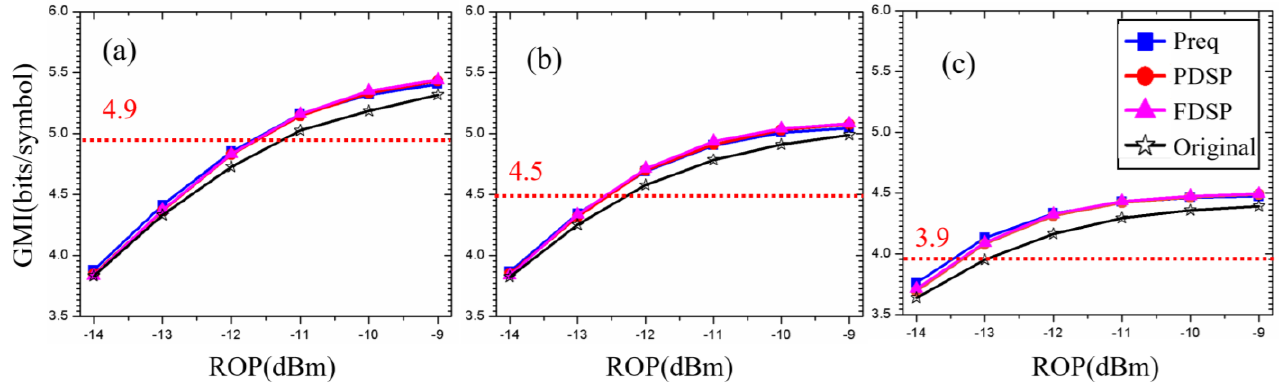
Figure 9. Measured GMI versus ROP for IRs of ( a ) 4.9, ( b ) 4.5 and ( c ) 3.9 bits/QAM symbol.